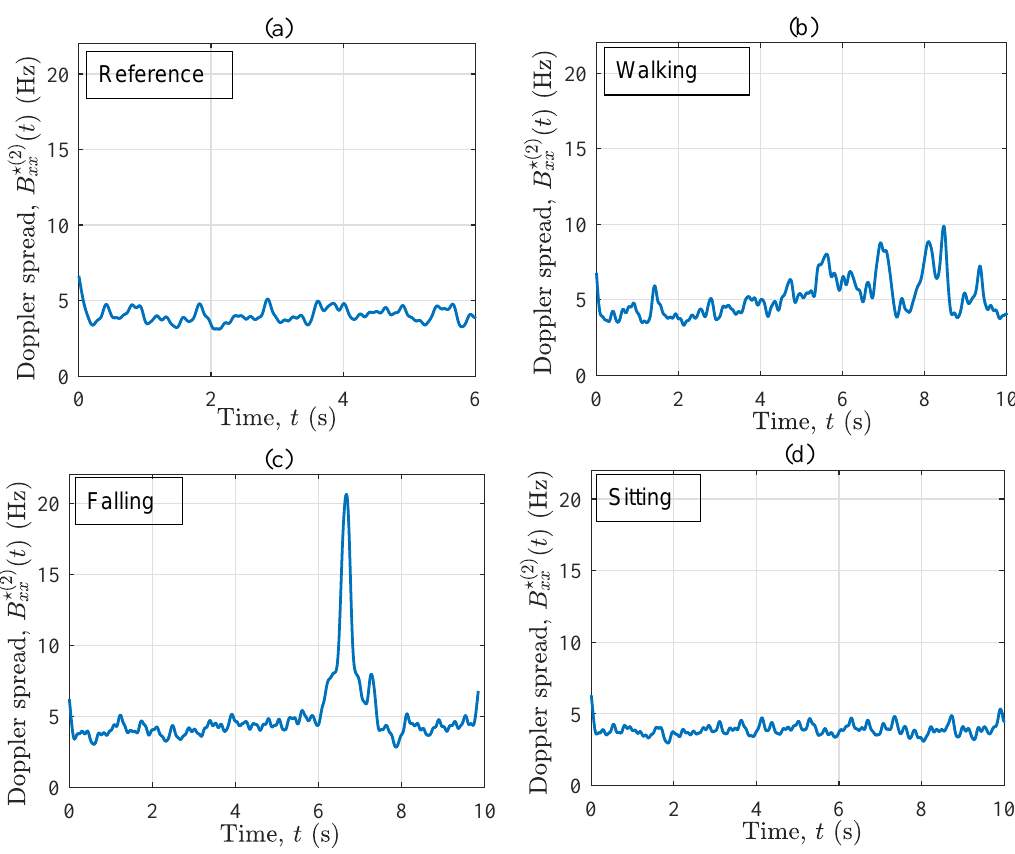
(cid:63) ( 2 ) ( t ) for the four scenarios in S2: ( a ) reference, xx